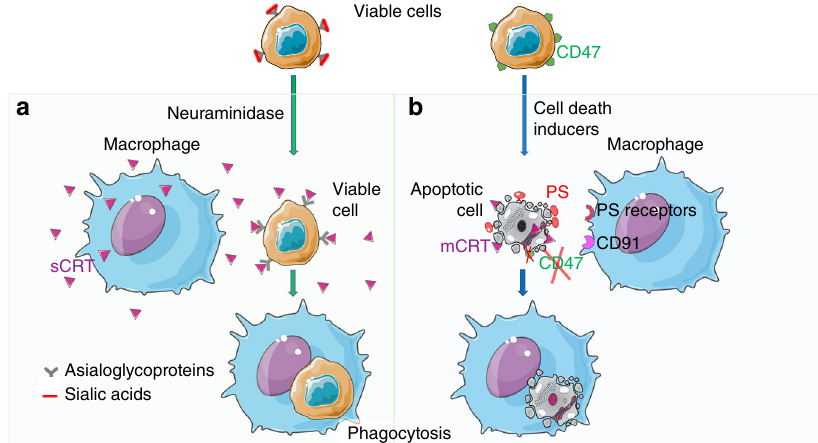
Fig. 1 Mechanisms of recognition of viable ( a ) and apoptotic ( b ) cells. a A soluble calreticulin (sCRT) secreted by activated macrophages is capable of binding to asialoglycans on viable target cells, depending on their developmental or damage state, which in turn, marks them for uptake. Neuraminidase-4 is one enzyme that could be involved in the generation of cell surface asialoglycans that bind sCRT. The cell-surface mCRT on the target cells can now interact with CD91, which is also known as low-density lipoprotein receptor-related protein 1 (LRP1). b CRT and CD91 have also been linked to immunogenic apoptotic cell death. On the surface of apoptotic cells expose phosphatidylserine (PS) and mCRT that function as “ eat me ” signals. The mCRT expression is particularly linked to cell death induced by agents that are known to induce immunogenic forms of apoptotic cell death. The expression of “ don ’ t eat me ” signals (e.g., CD47) on the apoptotic cells is either reduced or its location modi fi ed. Many membrane-bound receptors for PS have been reported, including those that bind PS directly or indirectly via bridging molecules. mCRT can bind CD91 on the phagocyte. The authors thank Servier for the fi gures that were produced using Servier Medical Art